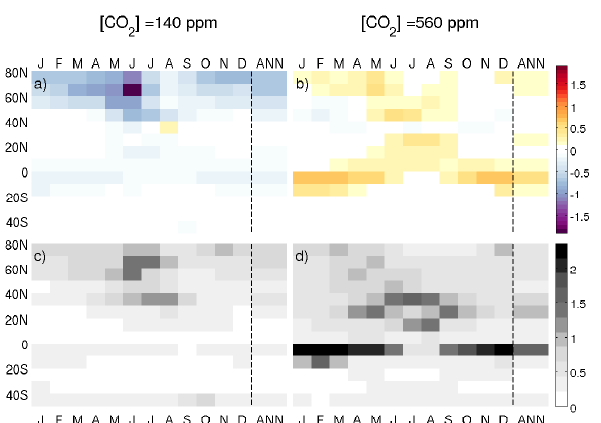
Table 3. Experiments